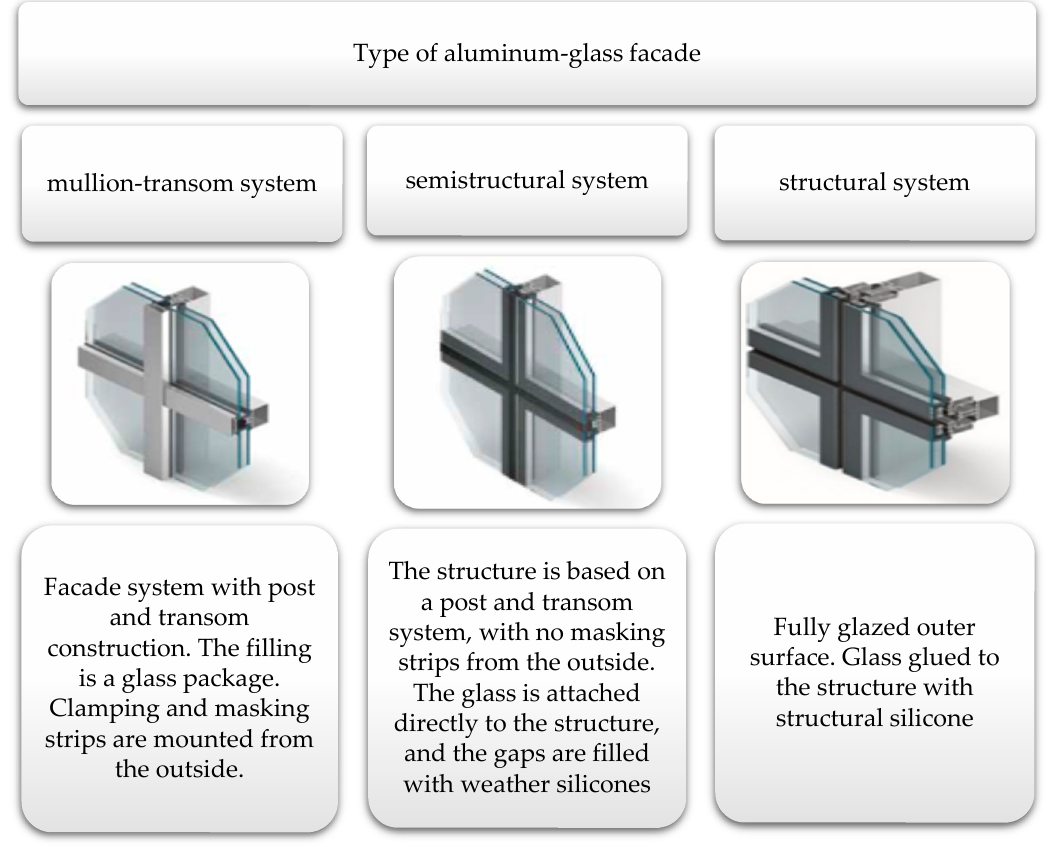
Figure 1. Type of aluminium–glass facades. Own study based on [26].